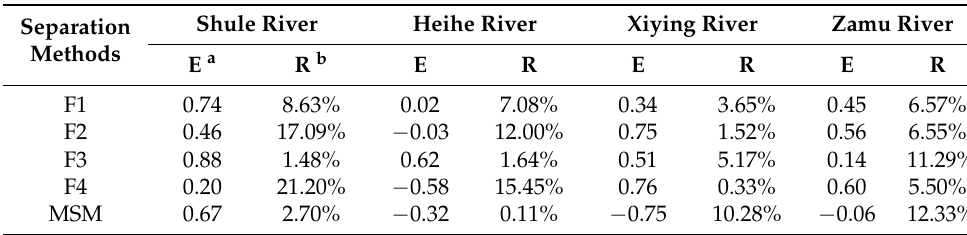
Table 3. Verification results of the inter-annual base flow separation methods applied to the Hexi inland rivers basin. Shule River Heihe River Xiying River Zamu River Separation Methods E a R b